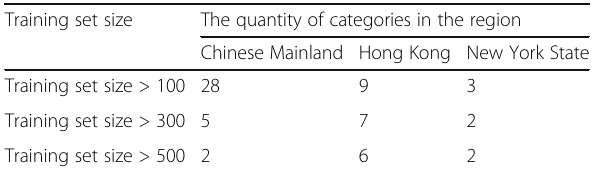
Table 2 Statistics of stable path ratio Training set size